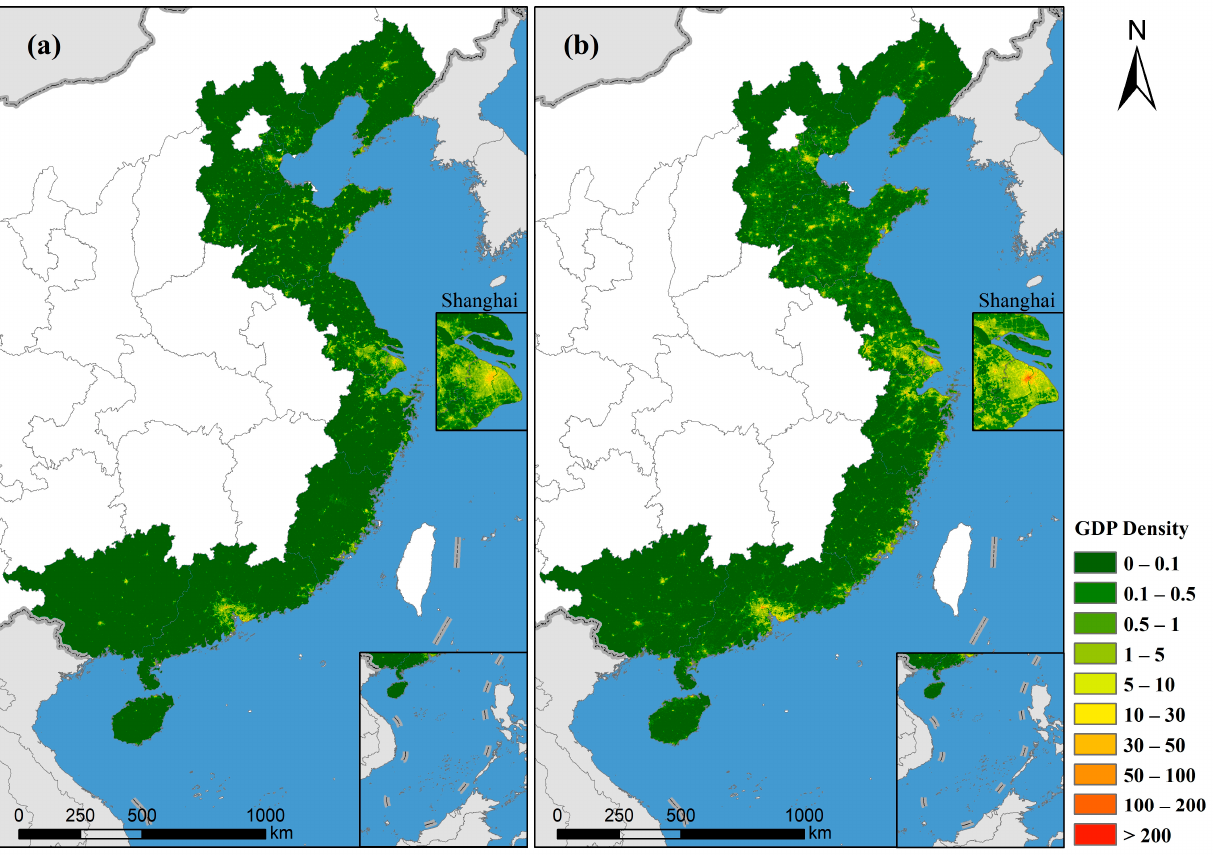
Figure 3. Total-GDP distribution of China’s coastal areas in ( a ) 2010 and ( b ) 2019 (unit: million CNY/ha).